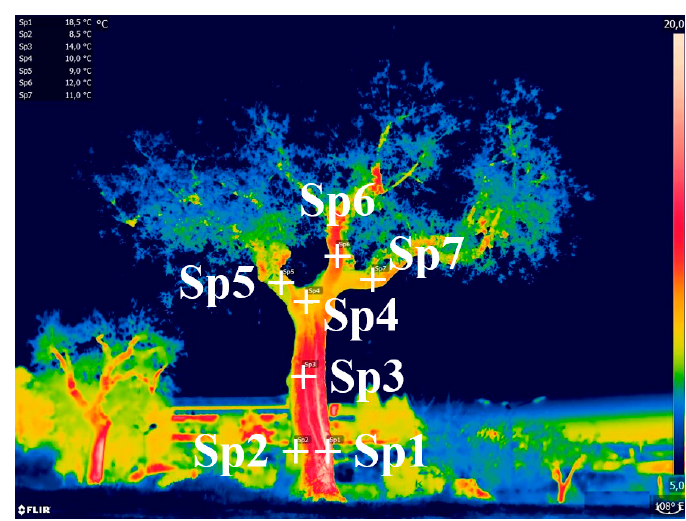
Figure 8. Photo ( A ) and thermogram ( B ) of the Quercus pyrenaica Willd tree. The white arrow shows an enlarged image of the CODIT development wall; the green arrow shows the same wall of CODIT on the thermogram; the red arrow indicates a stump. CODIT: compartmentalization of decay in trees.